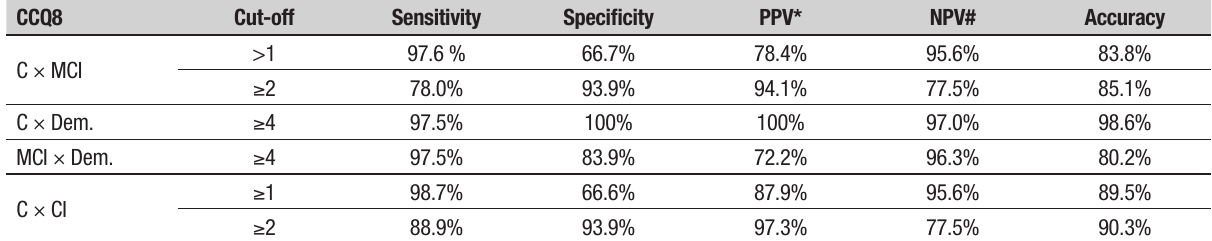
Table 3. Diagnostic properties of the CCQ8 among groups. CCQ8